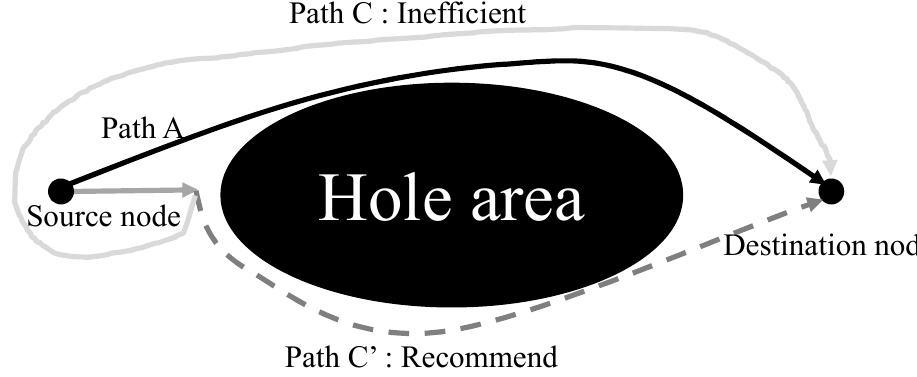
Figure 5. The inefficient problem near the hole area during multipath